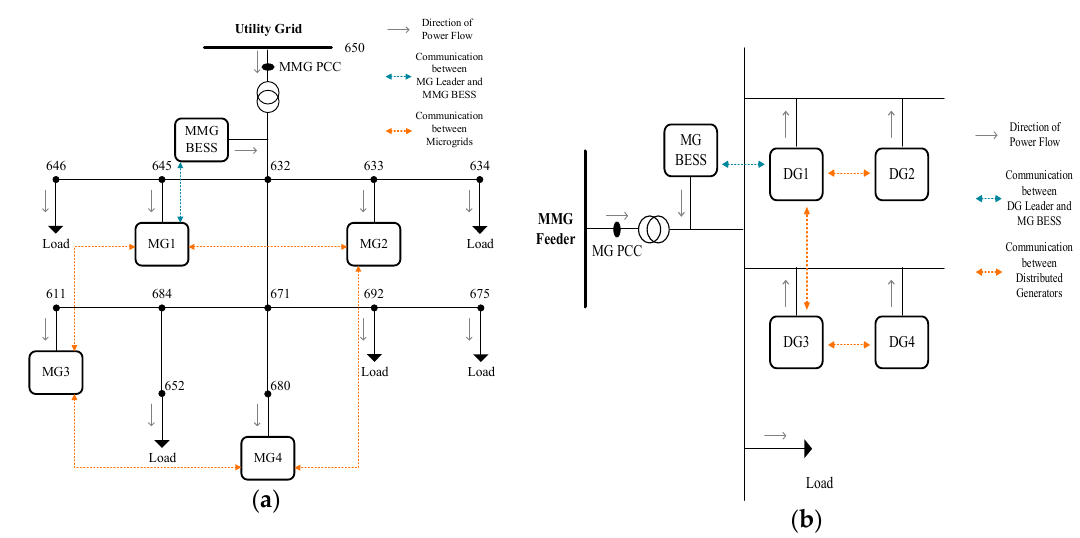
Figure 6. Test system. ( a ) MMG simulation model; ( b ) MG simulation model.